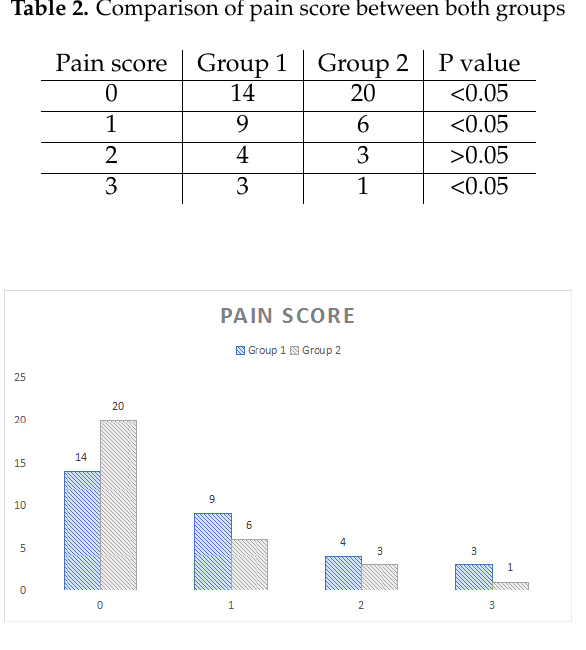
Figure 1. Graphically comparison of pain score between both